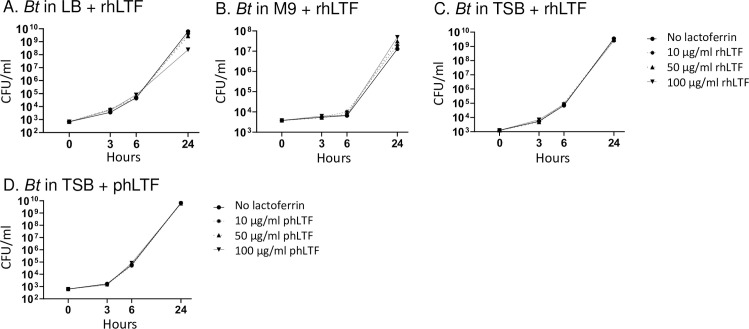
Lactoferrin does not impair growth of B. thailandensis in media.In the presence of varying concentrations of rhLTF, B. thailandensis (Bt) growth was quantified over 24 hours in A) LB, B) M9 or C) TSB media. In the presence of varying concentrations of phLTF, Bt growth was quantified over 24 hours in D) TSB media. Each graph is representative of at least two independent experiments.